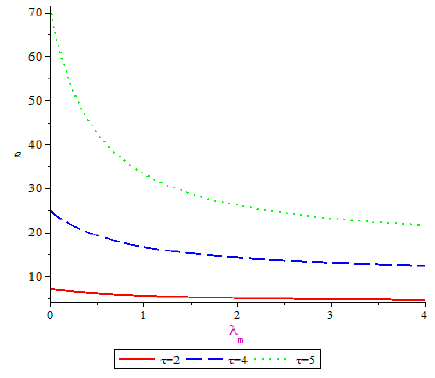
Figure 7. The impact of loss-aversion coefficient on green degree.